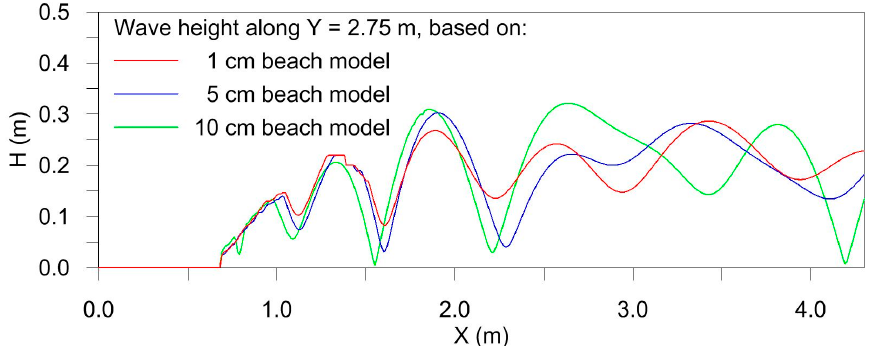
Figure 7. The wave height profile along Y=2.75 m for the modeling results based on beach models with 1, 5, and 10 cm resolutions.